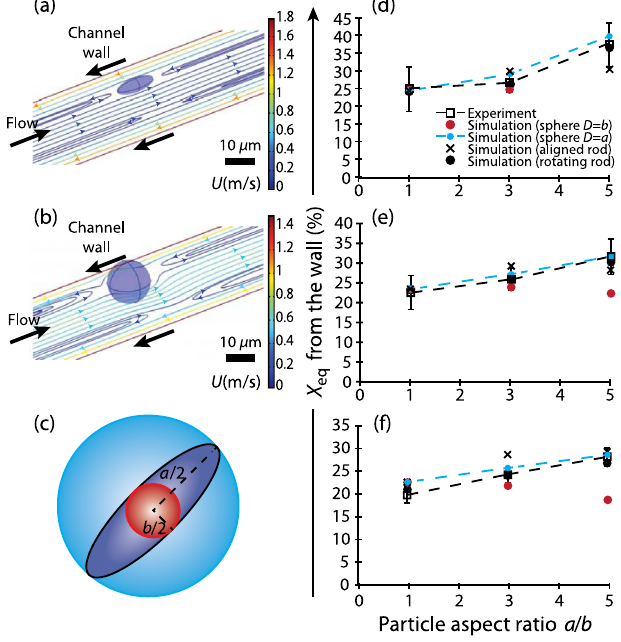
FIG. 4. Simulations allow accurate prediction of focusing positions for shaped particles. Simulation result and streamlines are shown for flow in the reference frame of (a) a focused rod and (b) a spherical particle in a straight channel. (c) Simulations are performed considering particle shape and aspect ratio with (i) the particle rotating (rotating rods) and (ii) the rod constrained from rotation (aligned rods), and also considering spheres with diameters that correspond to the rods’ (iii) longest dimension (spheres D ¼ b ) and (iv) smallest dimension (spheres D ¼ a ). (d),(e),(f) Comparison of equilibrium positions away from the wall, obtained by experiments and numerical simulations, for ¼ 0 : 53 , Q ¼ 50 (cid:1) L = min ; (e) AR ¼ 0 : 64 , Q ¼ (d) AR c c ¼ 0 : 74 , Q ¼ 110 (cid:1) L = min 40 (cid:1) L = min ; and (f) AR c